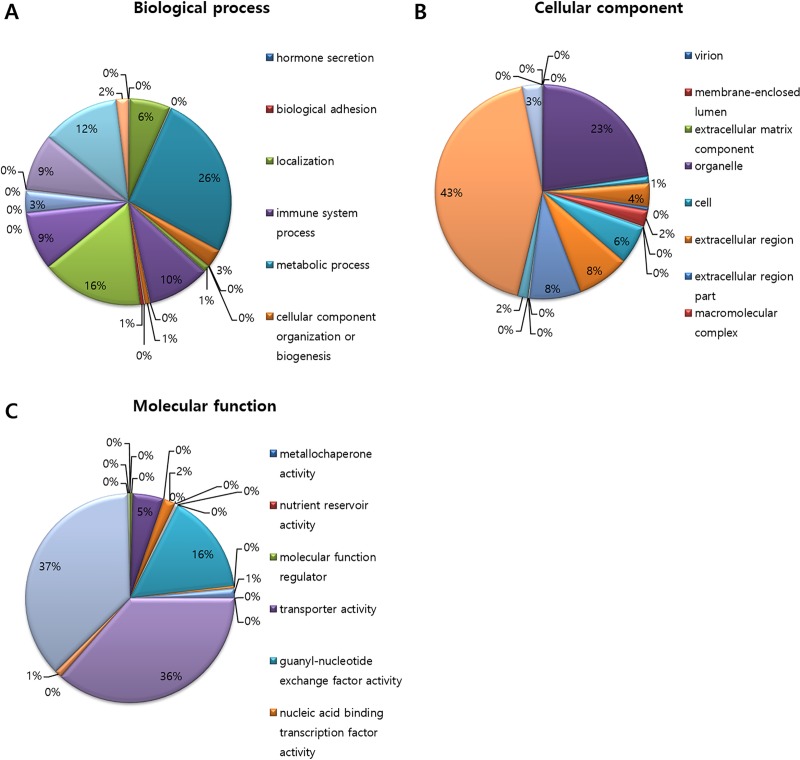
GO analysis of asparagus.(A: biological process, B: cellular component, C: molecular function).